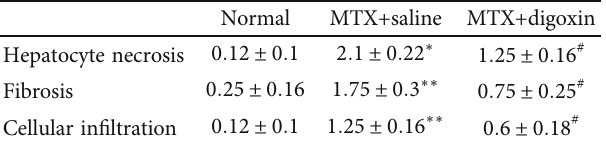
Table 1: Histological analysis of the results.